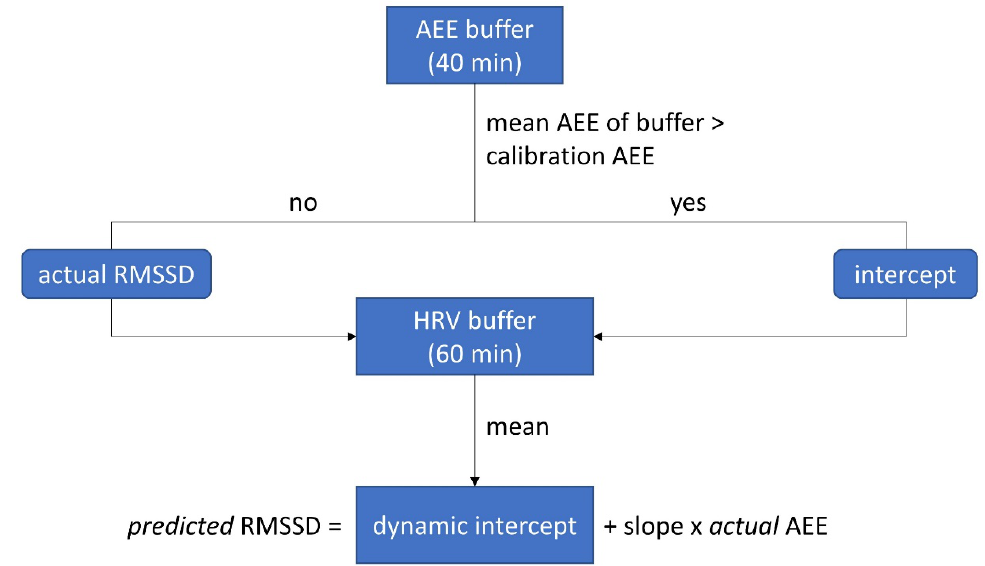
Figure 2. Decision tree of the dynamic intercept implemented in the dynamic AddHRVr algorithm.